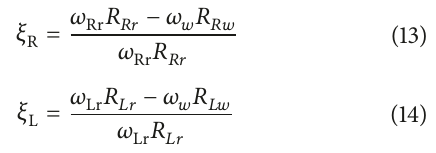
included in one single dynamic link library (.dll), which is called by the Simpack